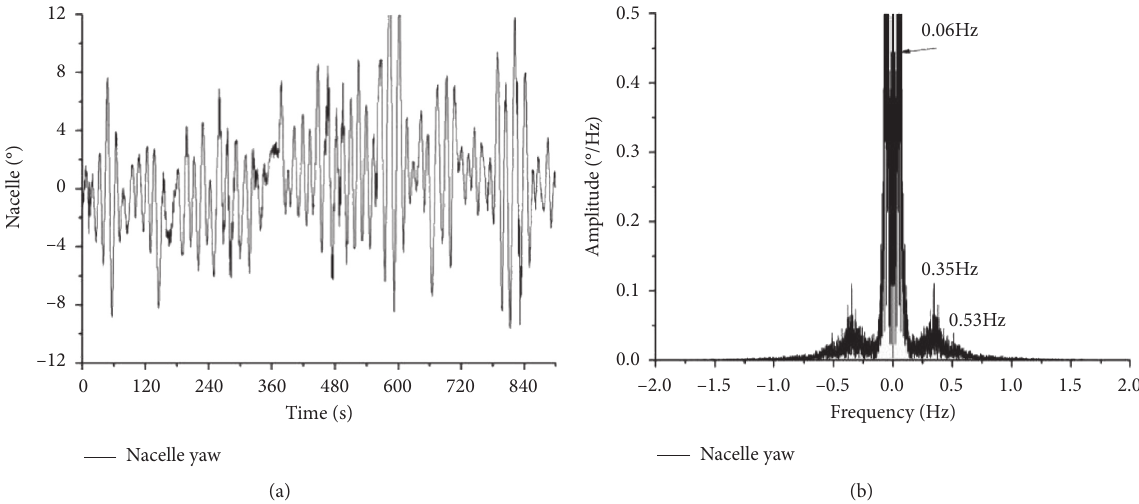
Figure 10: (a) Atomic change of hot-air balloon basket. (b) Hot-air balloon basket azimuth spectrum change.